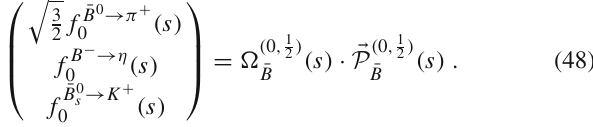
Table 3 Masses and decay constants (in MeV units) used in this work and taken from the PDG [1] and FLAG [22] reviews Goldstone Charm